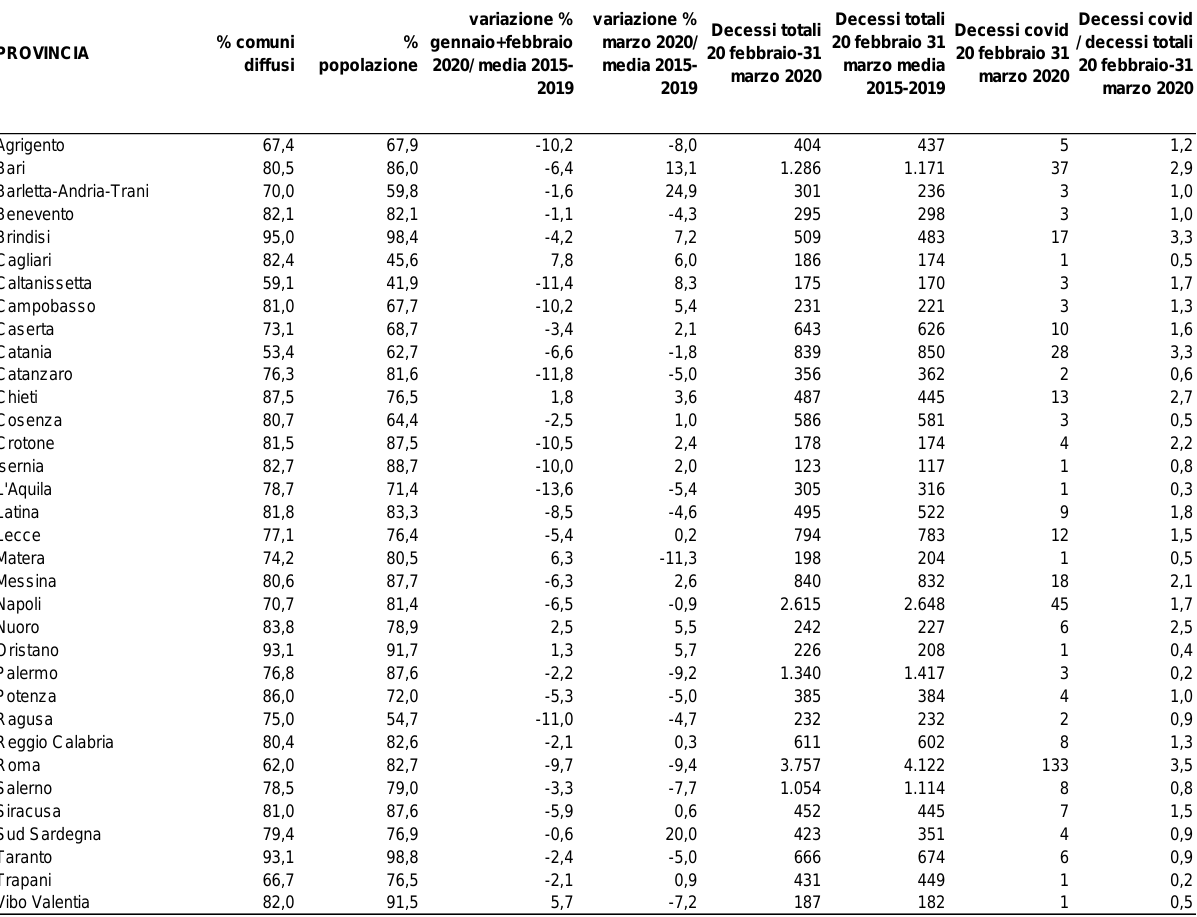
Tabella 4. Decessi per il complesso delle cause e per Covid-19 (a) nel